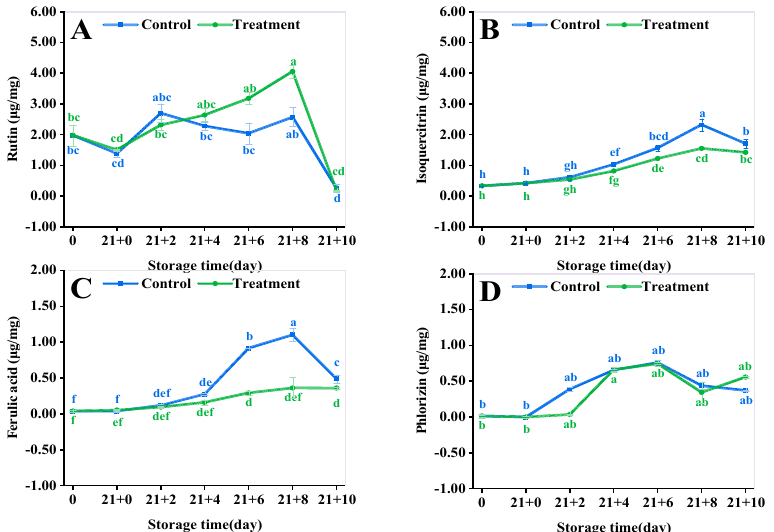
Figure 6. Different storage methods on yellow peach rutin ( A ), isoquercitrin ( B ), ferulic acid ( C ), and phlorizin ( D ). Vertical bars represent standard deviations. Different letters represent statistical differences ( p < 0.05).